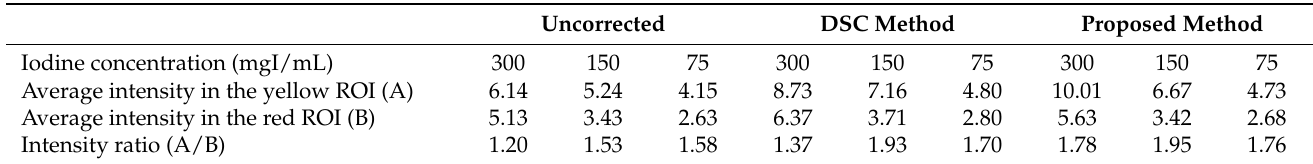
Table 1. The projection intensity at the ROI and the projection intensity ratio of the yellow ROI to the red ROI. Uncorrected DSC Method Proposed Method